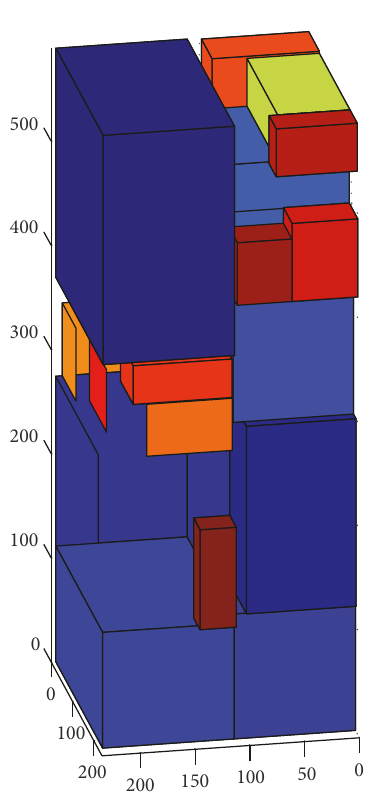
Figure 15: Strongly heterogeneous packing result.